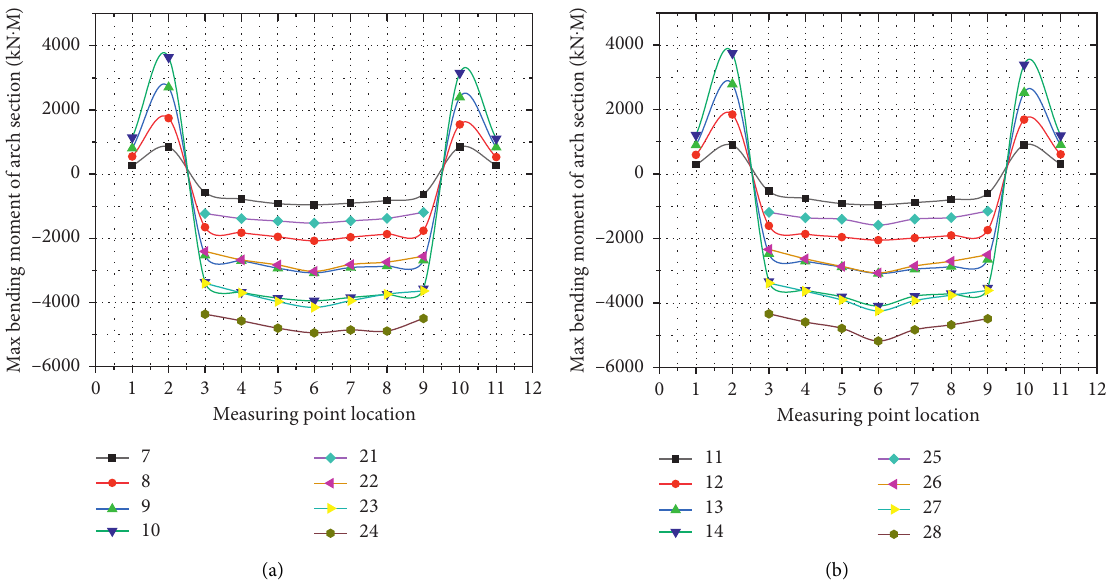
Figure 11: The maximum bending moment along the width of single segment and three segments under vertical loads. (a) Three-tenon type segment along width direction. (b) Four-tenon type segment along width direction.